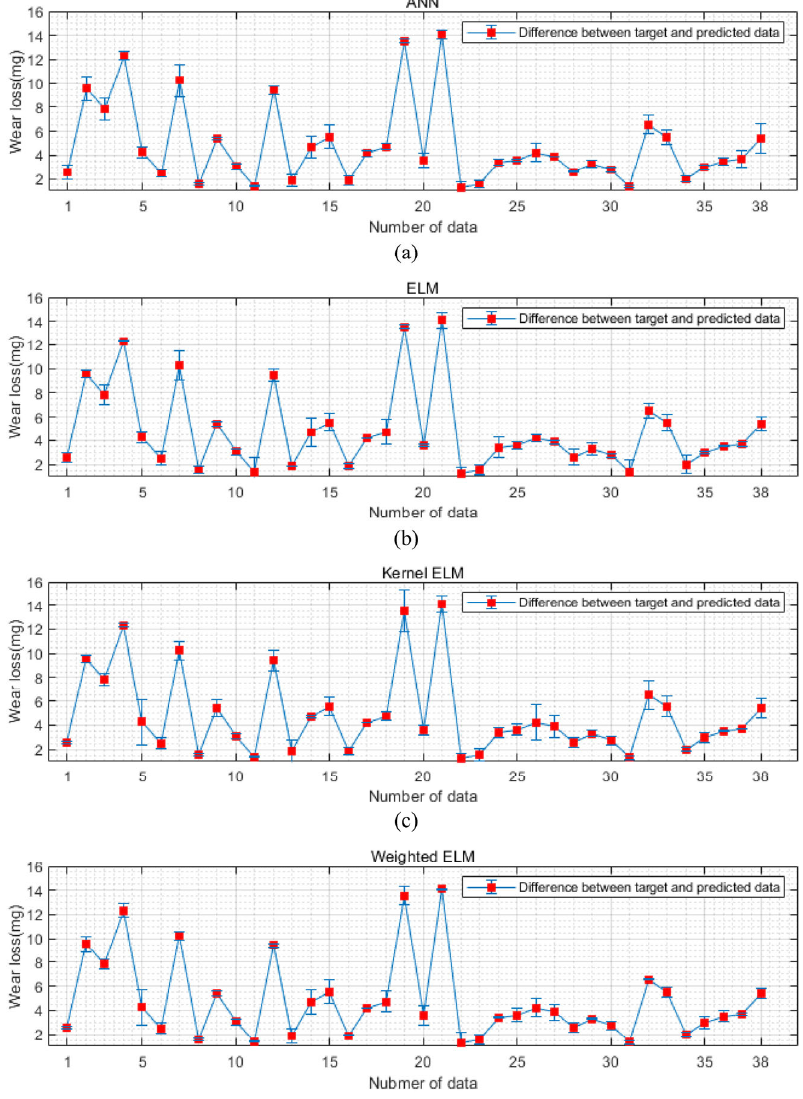
Fig. 6 Observed and predicted data with